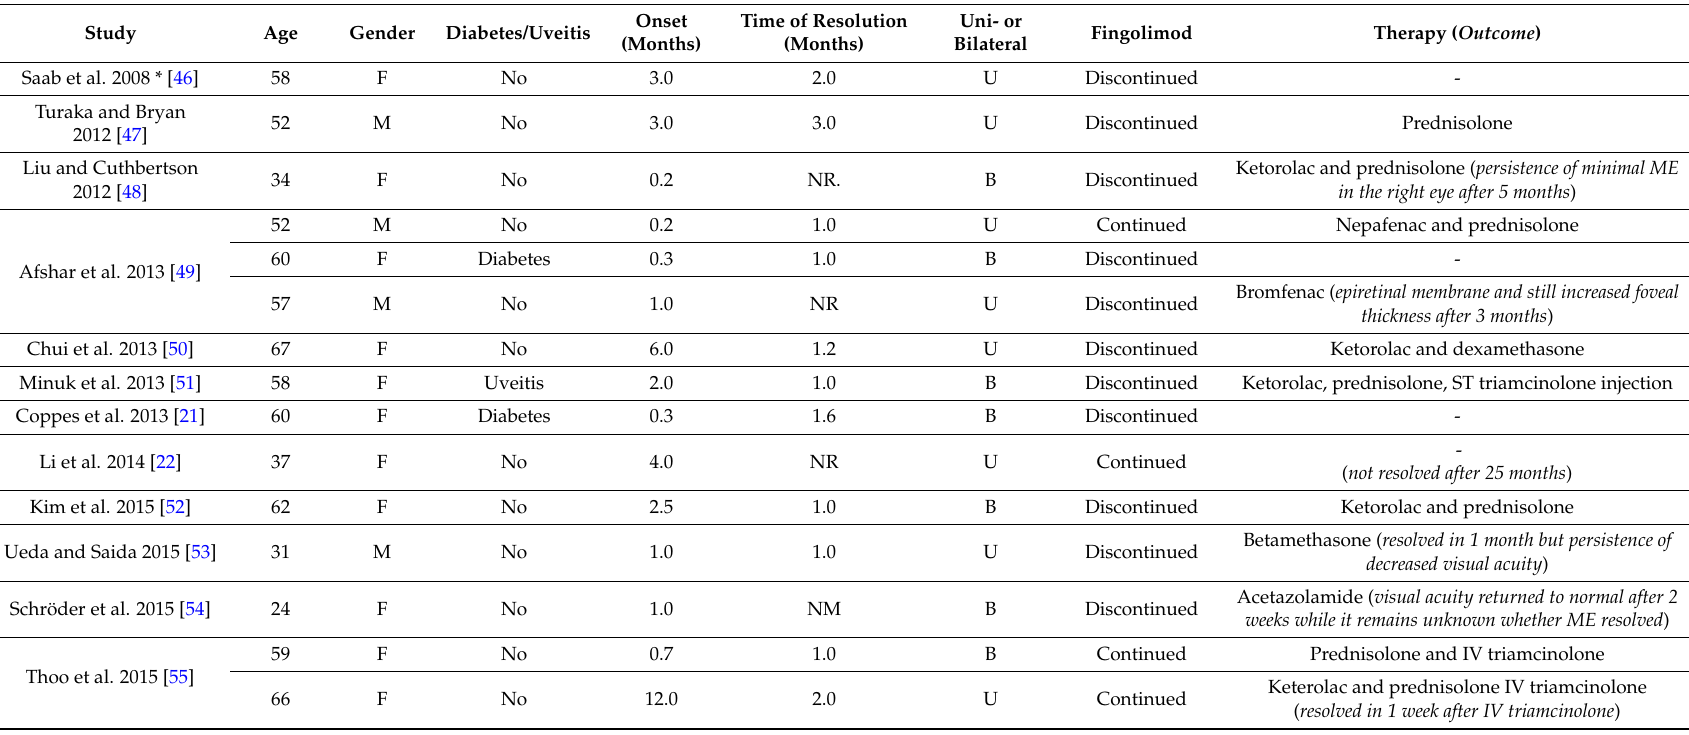
Table 4. Case studies of fingolimod associated macular edema in multiple sclerosis (MS) patients * except one subject who was a renal transplant recipient in a phase IIIb clinical trial of fingolimod. M = male; F = female; U = unilateral; B = bilateral; ST = subtenon; IV = intravitreal; R = resolved; NR = not resolved; NM = not